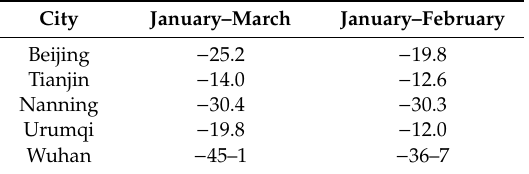
Table 3. Relative percentage change in NO 2 from 2019 to 2020. Source: